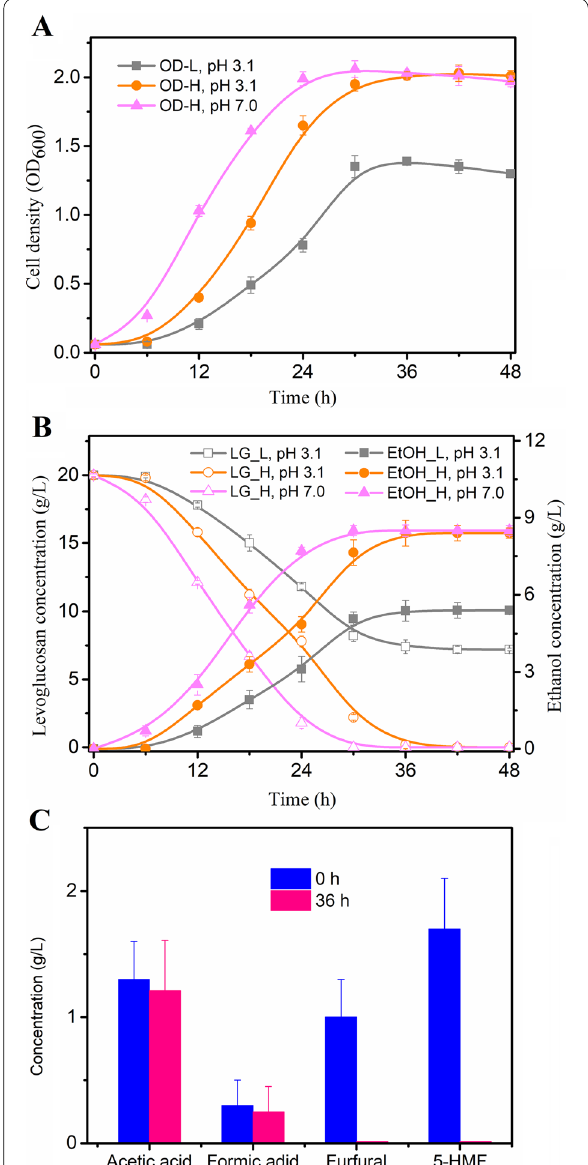
Fig. 2 Cell growth, ethanol fermentation, and inhibitor conversion of the evolved E. coli -L and E. coli -H in bio-oil based minimal media. A Cell growth. OD-L and OD-H denote the OD 600 values of E. coli -L and E. coli -H, respectively. B Levoglucosan consumption and ethanol production. LG-L and LG-H denote the levoglucosan residues after consumed by E. coli -L and E. coli -H, respectively, and EtOH-L and EtOH-H the respective ethanol concentrations produced by them. C Acetic acid, formic acid, furfural, and 5-HMF concentrations before (0 h) and after (36 h) fermentation. Conditions: 30 °C, 200 rpm, pH 3.1 or 7.0. Mean values were presented with error bars representing at least two standard